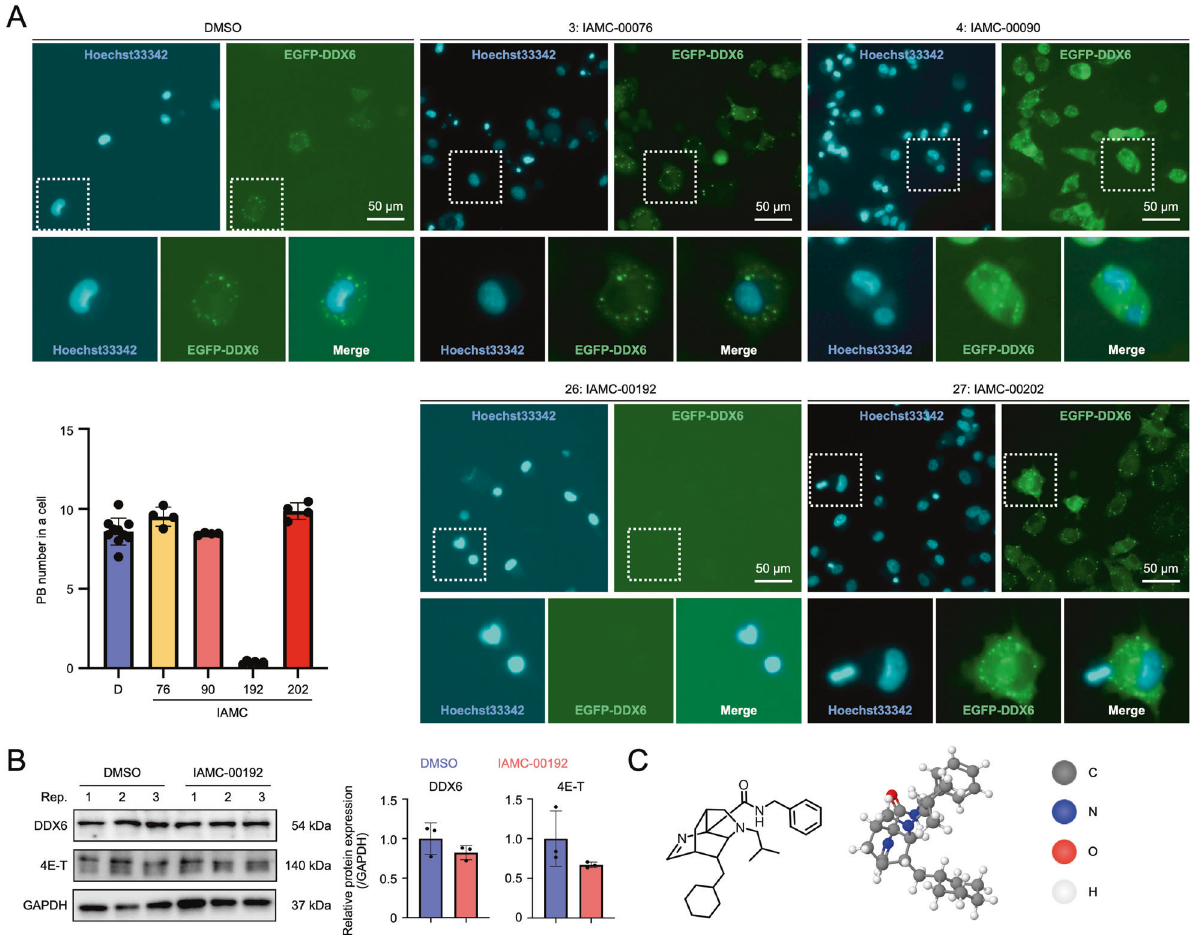
Fig. 2 Inhibition of PB formation by the small molecule inhibitors. A Exposure experiments of candidate factors inhibiting RNA degradation to A549 EGFP-DDX6. GFP foci are PB. Nuclei were stained with Hoechst33342. The graph shows the number of intracellular PBs when each small molecule inhibitor was added. B Protein expression analysis of A549 when a small molecule inhibitor IAMC-00192 was added using Western blotting. Each graph shows the result in triplicate. C Structure of IAMC-00192. The molecular model on the right is the 3D structure described by MolView